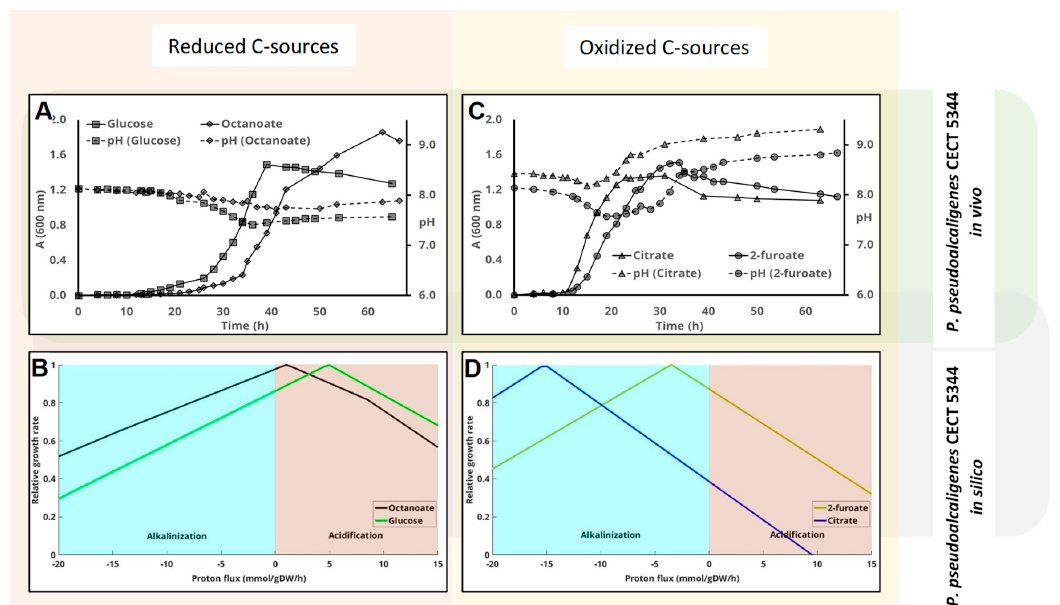
Figure 4. Influence of the carbon source on pH change in P. peudoalcaligenes CECT 5344 cultures. Cells were inoculated in M63 media containing different carbon sources. Cell-growth (solid lines, A 600 nm ) and pH change (dashed lines) were measured at the indicated times. Glucose and octanoate, which are considered reduced carbon sources, are plotted together (panel ( A )), whereas panel ( C ) shows the results obtained using more oxidized carbon sources (citrate and 2-furoate). Panels ( B , D ) represent the predicted influence of proton flux (negative implies uptake and therefore alkalinization of the medium) on the growth rate using the genome scale metabolic model of this strain as indicated in the M&M section.